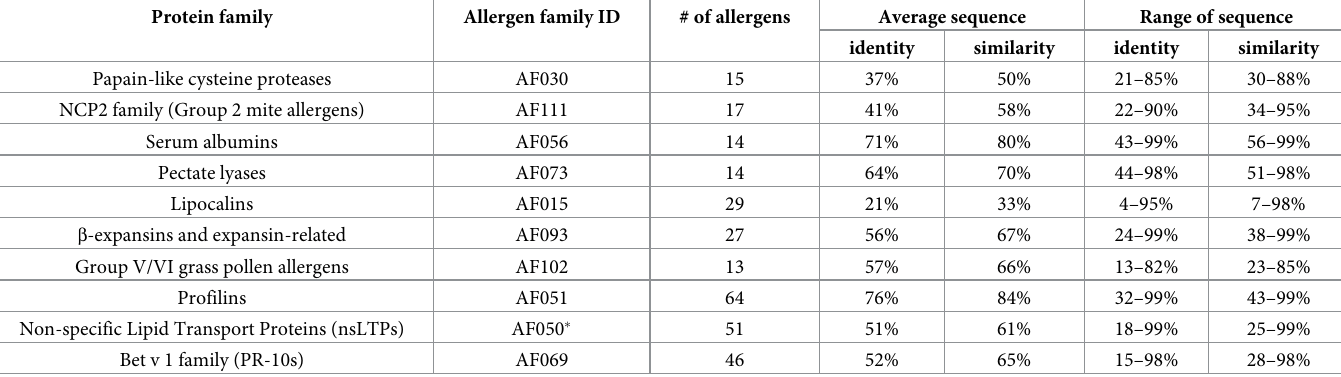
Table 1. Summary on selected allergen families. A � indicates prolamin superfamily [5], however only nsLTPs are taken into account. Protein